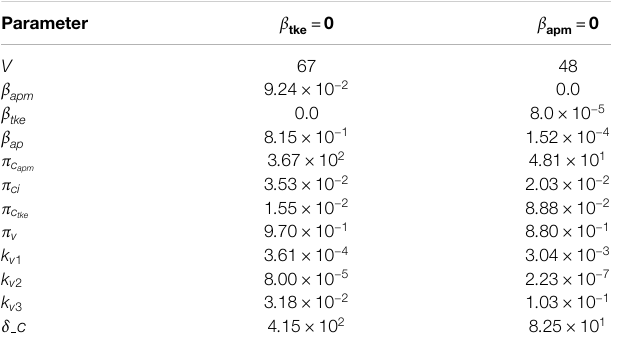
TABLE7| Modelparametersvaluesthat fi tnon-survivors ’ data,whenconsidering that only APCs ( β tke (cid:1) 0) or only T CD8 + cells ( β apm (cid:1) 0) are infected by SARS- CoV-2. Theparameter presentedin Table 2 werere-estimated using DE.All other model parameters values were those from Table 5 .